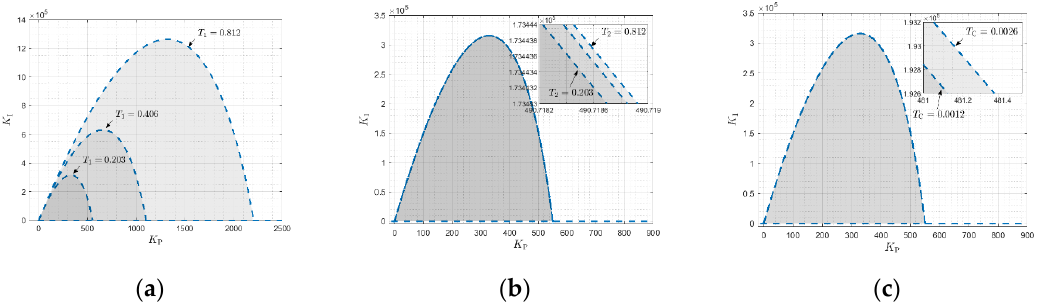
Figure 8. Global stability region of the control structure for different value of the plant’s parameters: time constant of the driving motor ( a ), time constant of the load machine ( b ) as well as time constant of the elastic shaft ( c ).